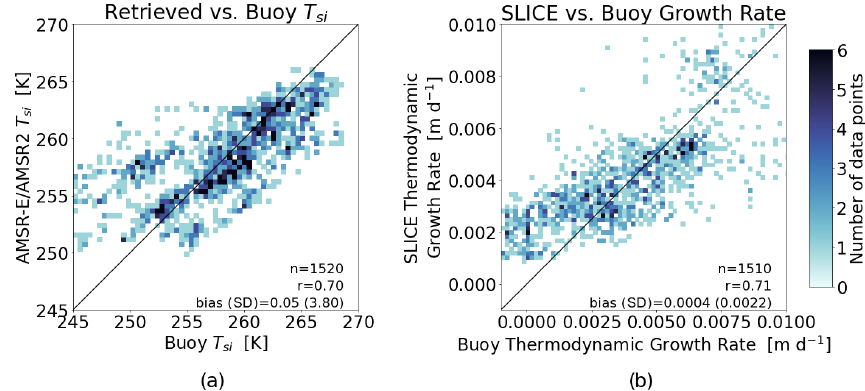
Figure 3. An instantaneous comparison of (a) AMSR-E/AMSR2 retrieved snow–ice interface temperature to buoy snow–ice interface tem- perature and (b) SLICE retrieved thermodynamic growth rate using buoy thickness to buoy thermodynamic growth rate. Linear correlations are 0.70 and 0.71,